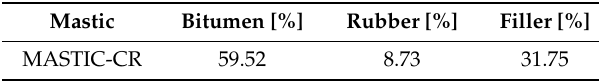
Table 5. Mastic percentage composition (by weight).